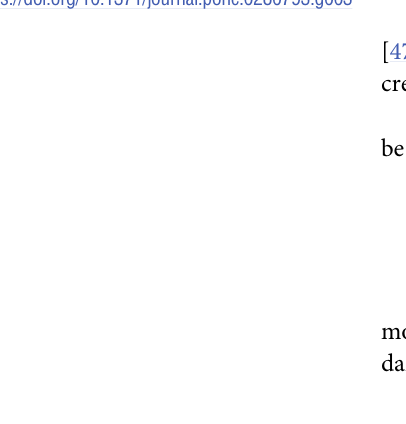
= 0 and shear slip of the rock mass occurs along the shear b